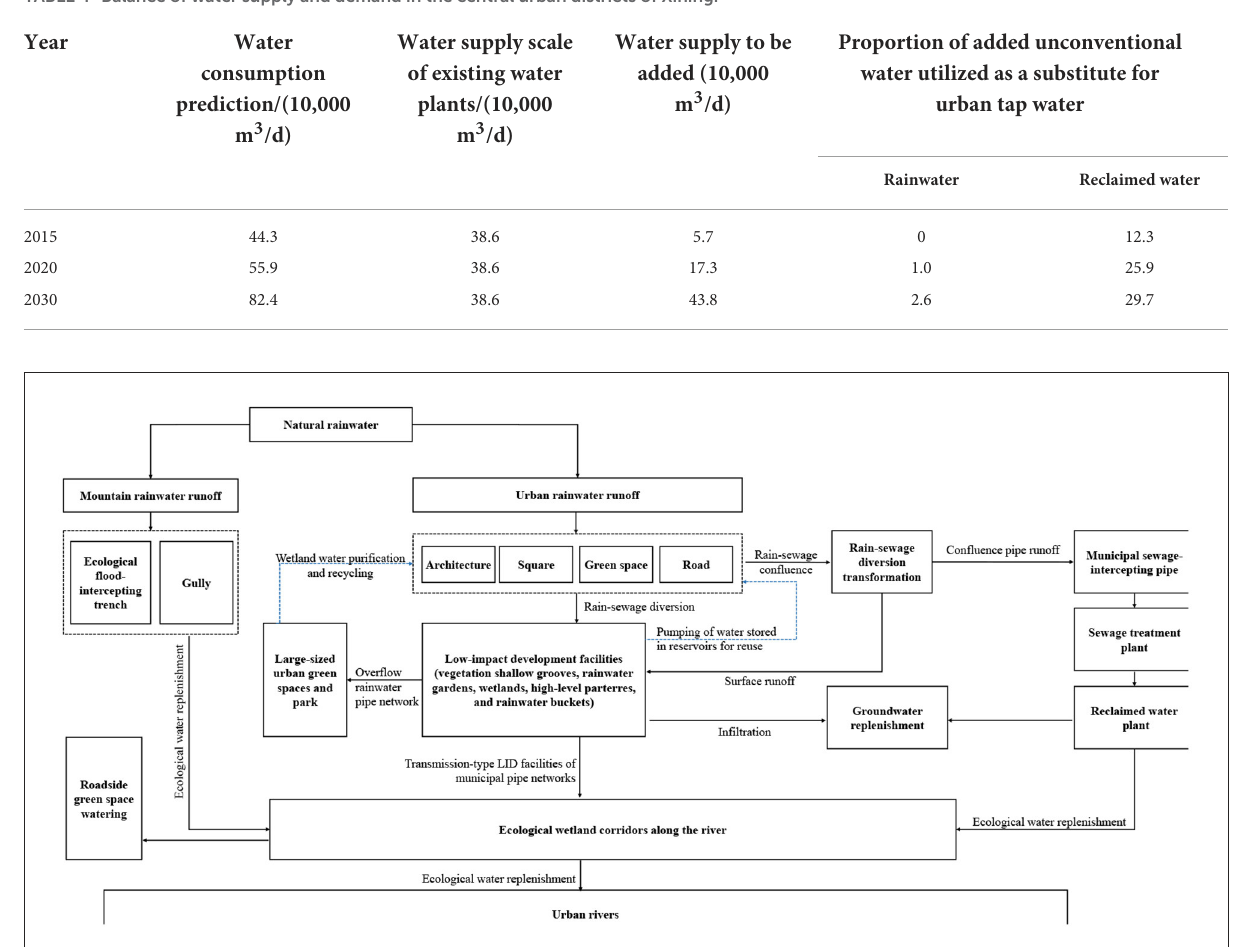
FIGURE12 Flow chart of comprehensive rainwater utilization in the sponge city construction of Xining.